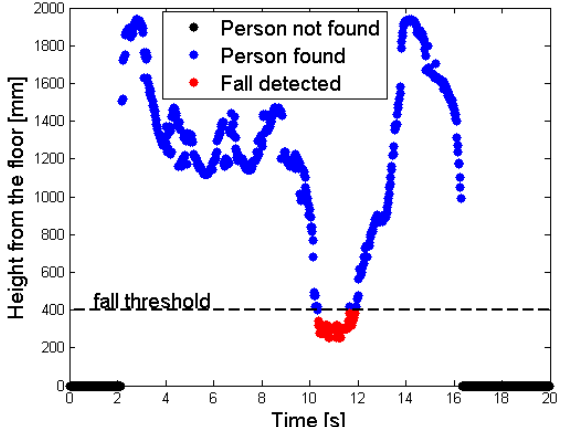
Figure 13. Time sequence of the depth values assumed by the person’s central point ( cp parameter), in the complex scenario, with the RF frame: the fall event is detected.